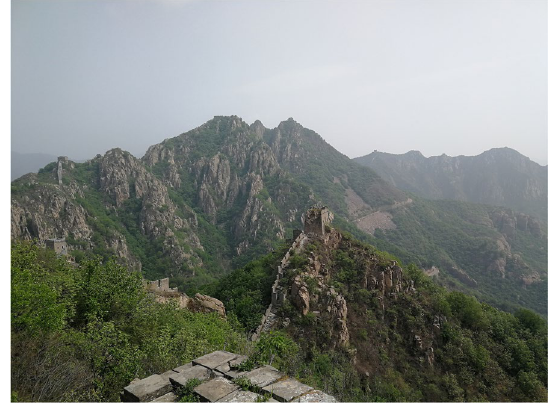
Fig. 2 The unrestored Ming Great Wall is becoming part of the landscape (Source: Tongji-ACL, taken in Liaoning Province)